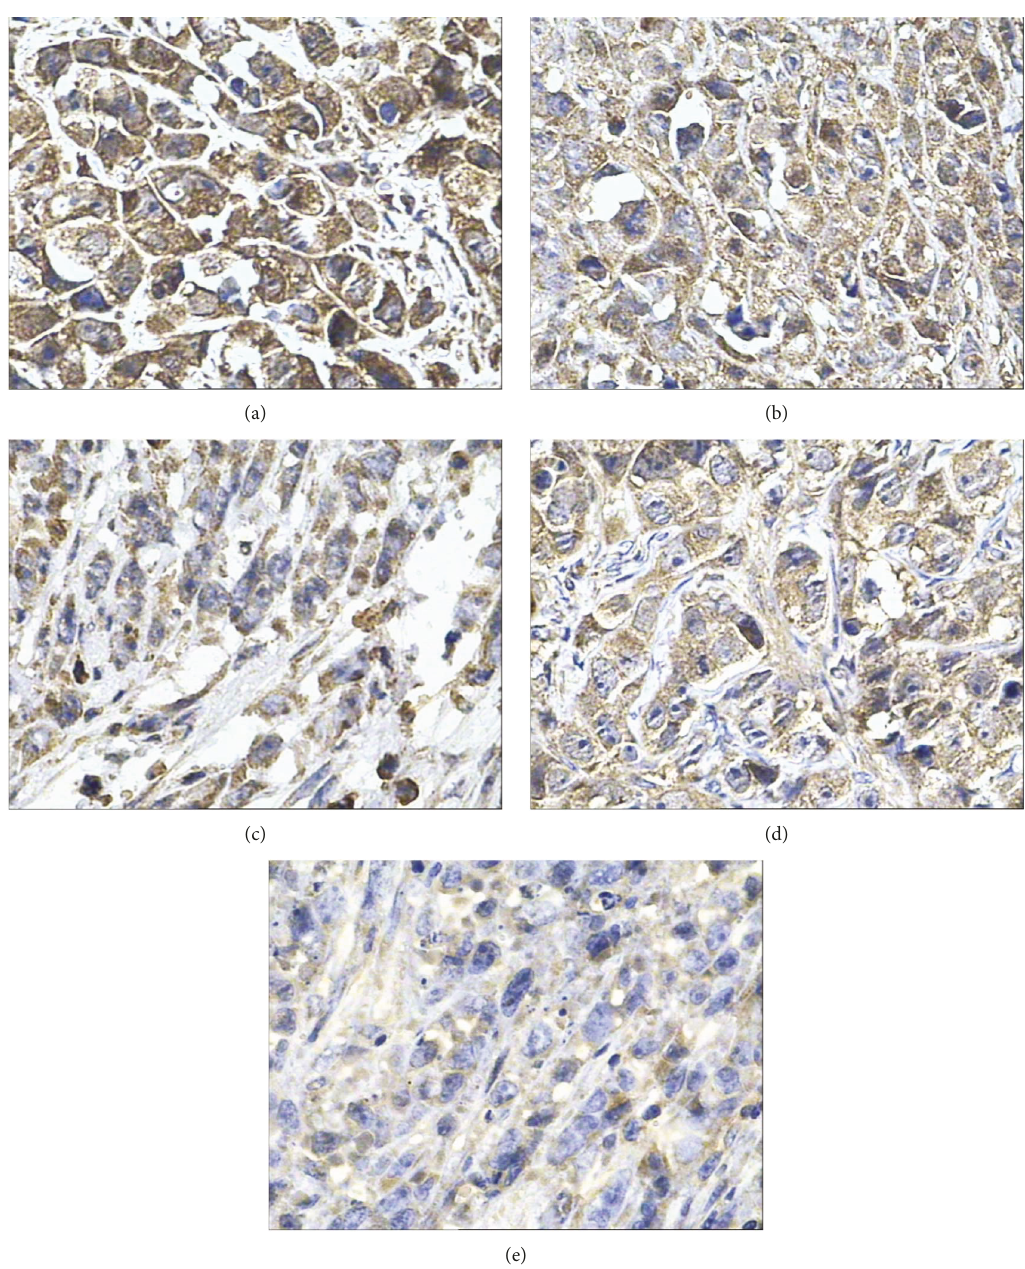
Figure 4: Bcl-2 protein expression in hepatoma tissues after di ff erent treatments tested by IHC (400x): (a) Saline control group. (b) Radionuclide group. (c) Radionuclide-gene group. (d) MFH group. (e) Radionuclide-gene-MFH